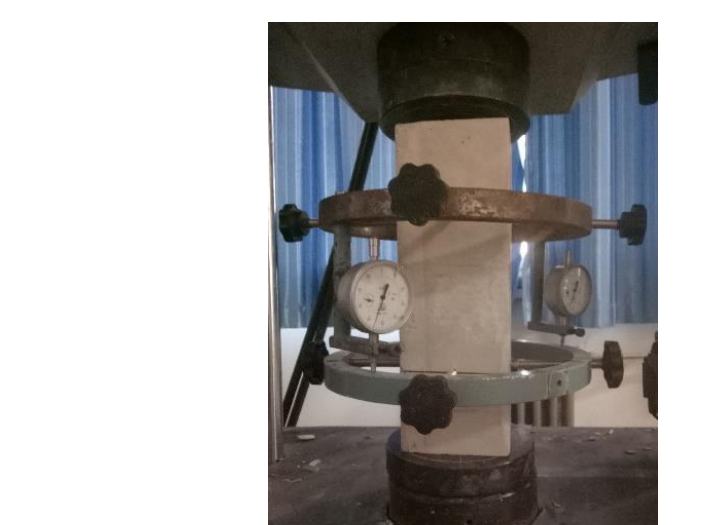
Figure 2. Elastic modulus test of prism.